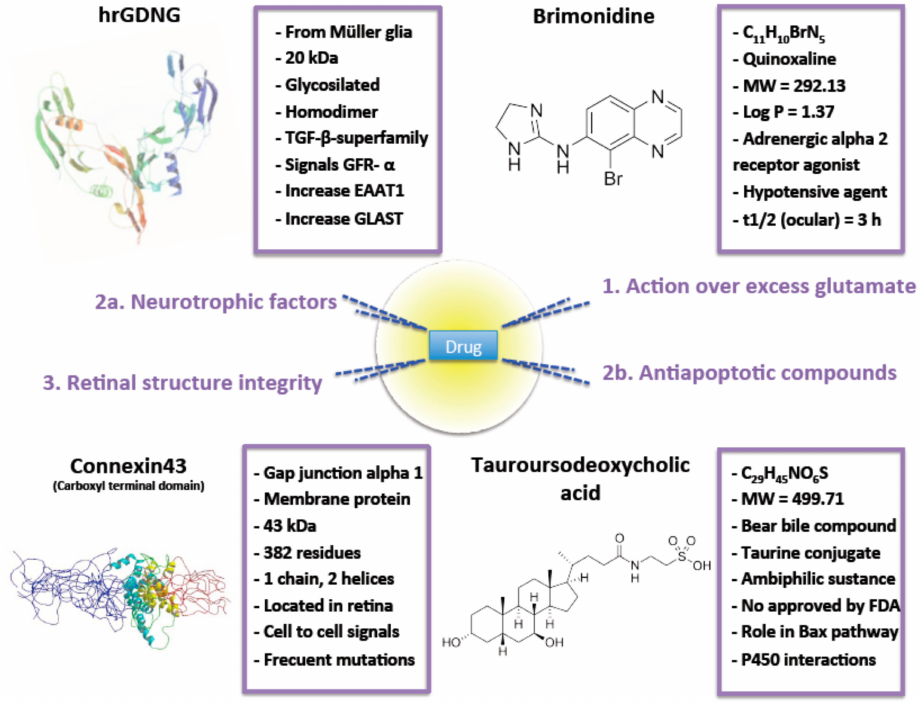
Figure 2. Drugs incorporated into microparticles to treat excitotoxicity. For each compounds the principal characteristics are